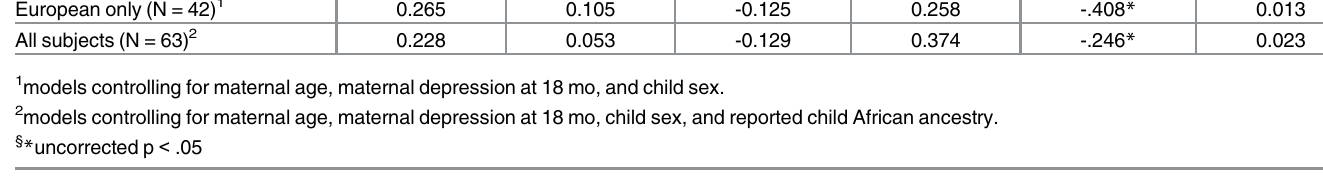
models controlling for maternal age, maternal depression at 18 mo, child sex, and reported child African ancestry. § * uncorrected p < .05